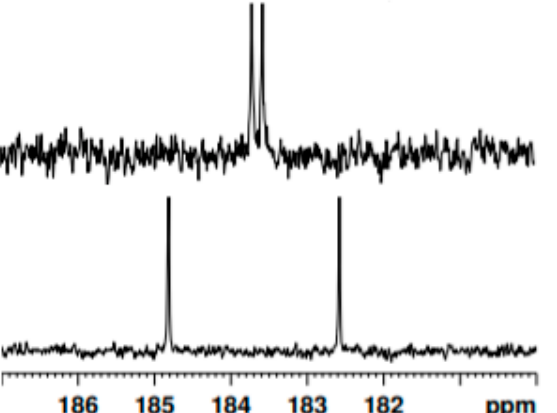
Figure 8. 13 C-NMR of species 2 ( up ) and species 3 ( down ) in dichloromethane- d 2 , which only shows quaternary carbon C-O.